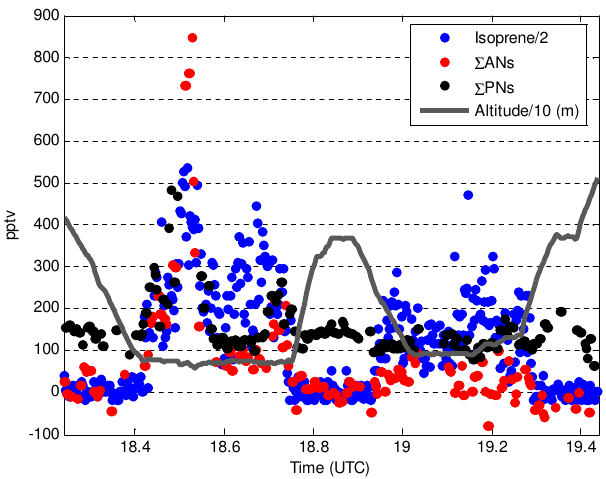
Fig. 1. An example from flight #23 (10 July 2008) of the 6 ANs, 6 PNs, and isoprene (from the PTRMS) concentrations versus hour (UTC). The solid line is the altitude of the DC-8 aircraft. The data is from the 10s merge, version